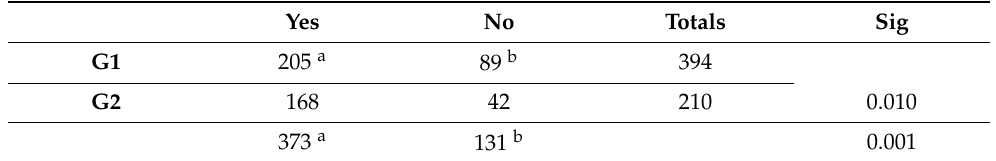
Table 3. Responses between G1 (15–40 y old) and G2 (40+ y old) to the question ‘Do you stick to a particular brand of fibre-rich feed (i.e., a feed with >18% crude fibre)? Yes